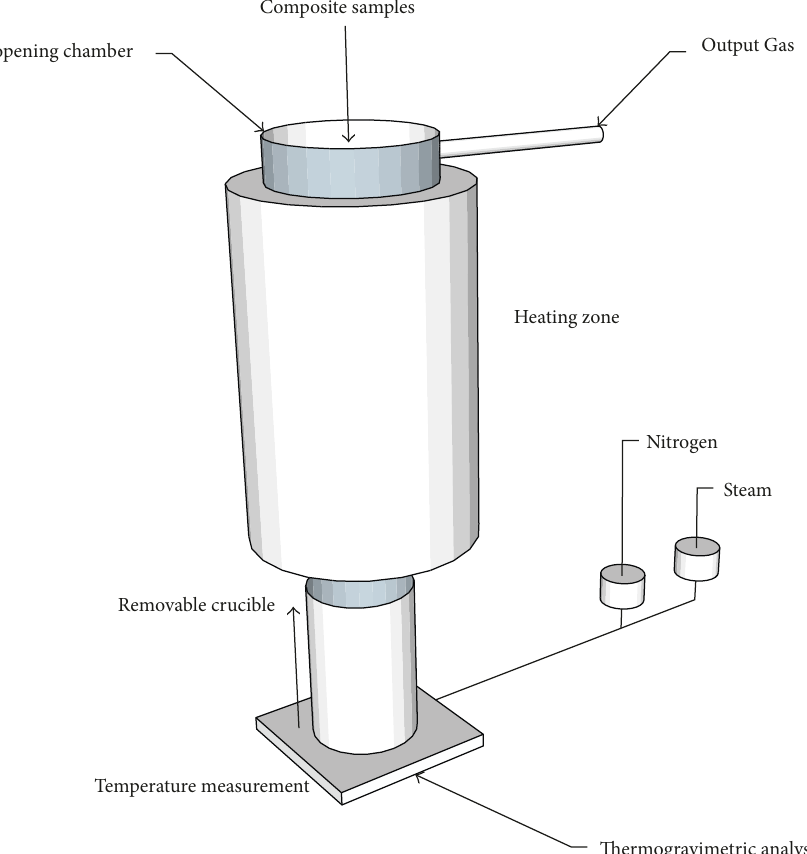
Figure 1: A schematic diagram for the recycling